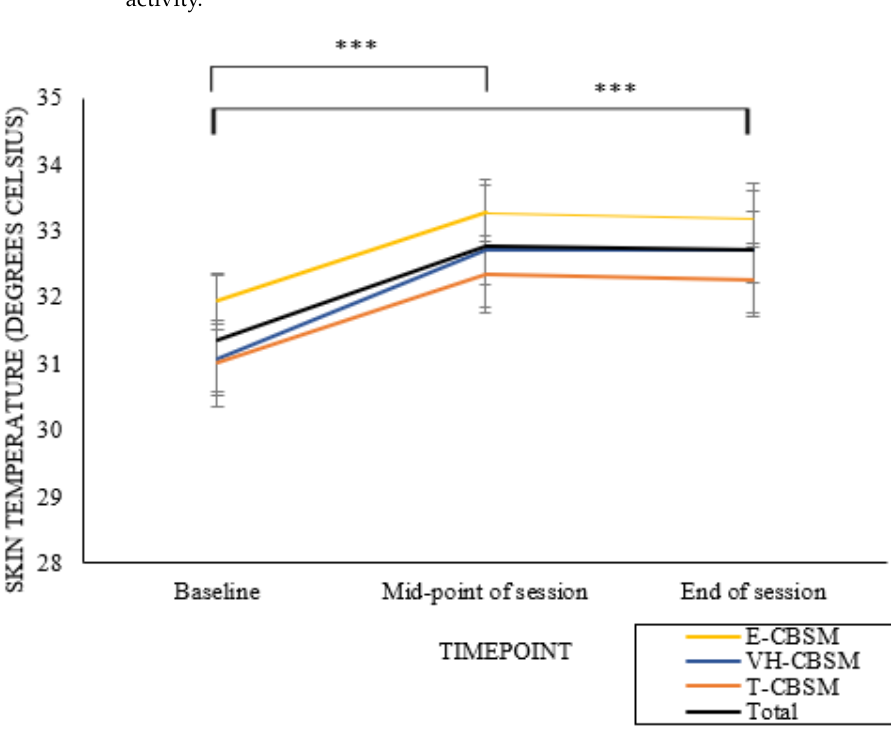
Figure 5. A significant main effect of time on skin temperature. Note, standard error bars are depicted (*** p < 0.001).